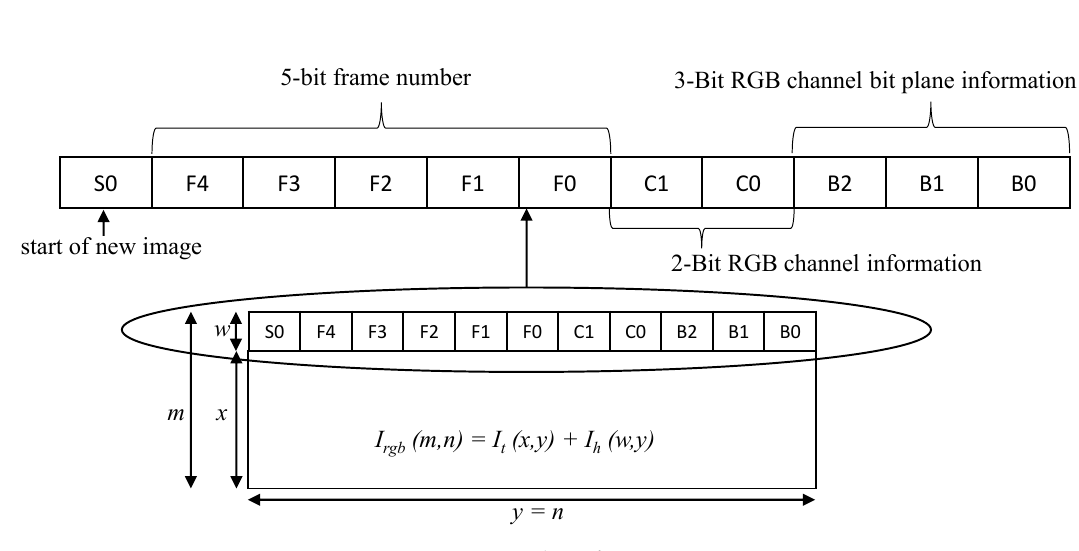
Figure 3. Header